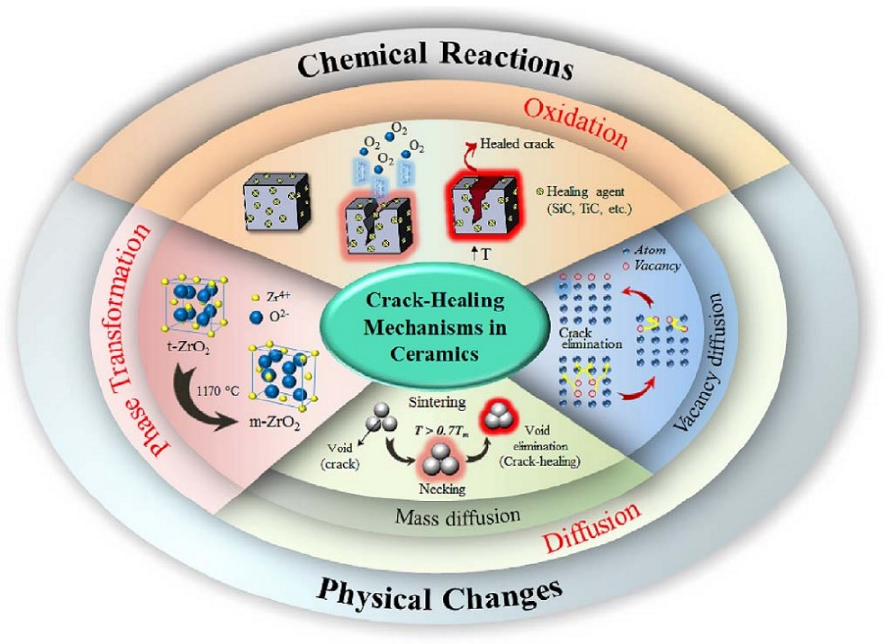
Figure 3. Crack-healing mechanism in ceramics [45].